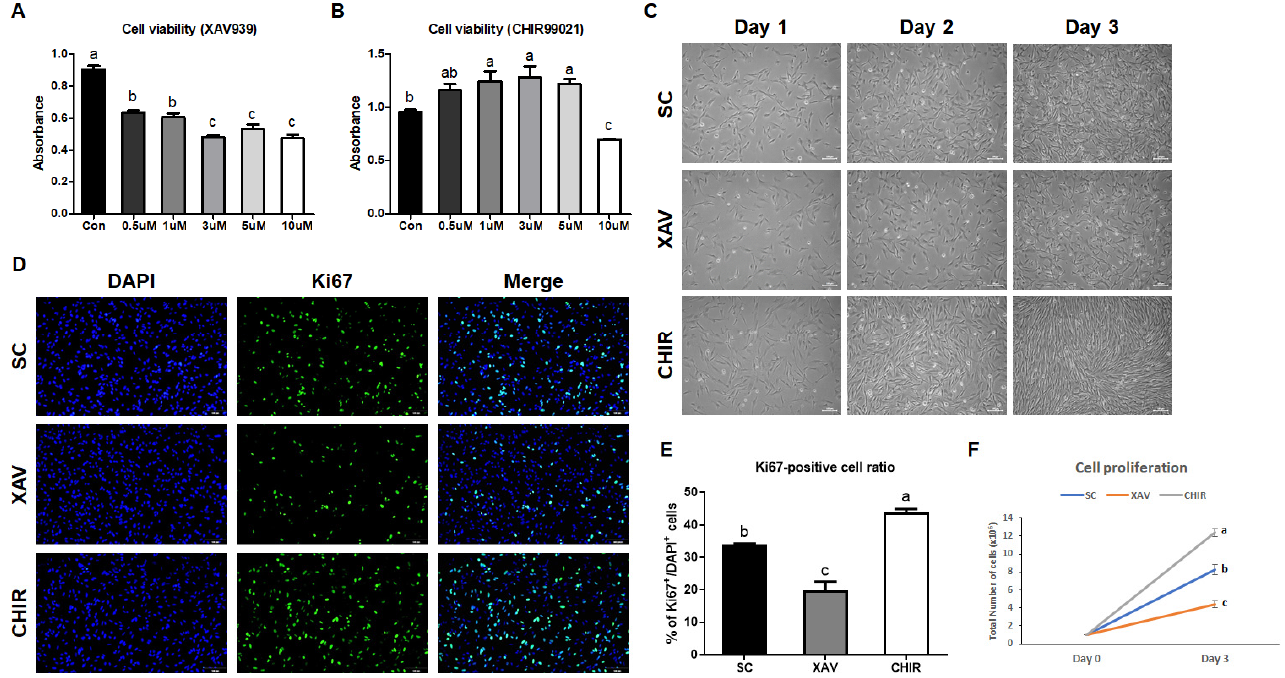
Figure 1. Effect of small molecule addition on porcine muscle satellite cells (PMSCs). ( A , B ) Viability of PMSCs according to XAV939 or CHIR99021 doses at 72 h. ( C ) Morphology of PMSCs in each group. ( D ) Immunostaining images of PMSCs for comparison of proliferation rates. Cell nuclei were stained with DAPI (blue) and Ki67 (green). ( E ) The ratio of Ki67 + /DAPI + cells shown in the immunostaining images. ( F ) Comparison of proliferation rate of PMSCs. SC, control group; XAV, treated with 1 µ M of XAV939; CHIR, treated with 3 μ M of CHIR99021. Values are presented as mean ± SE. a–c Different letters represent statistically significant differences among treatment groups ( p < 0.01). Scale bar, 100 μ m (Figure S2).